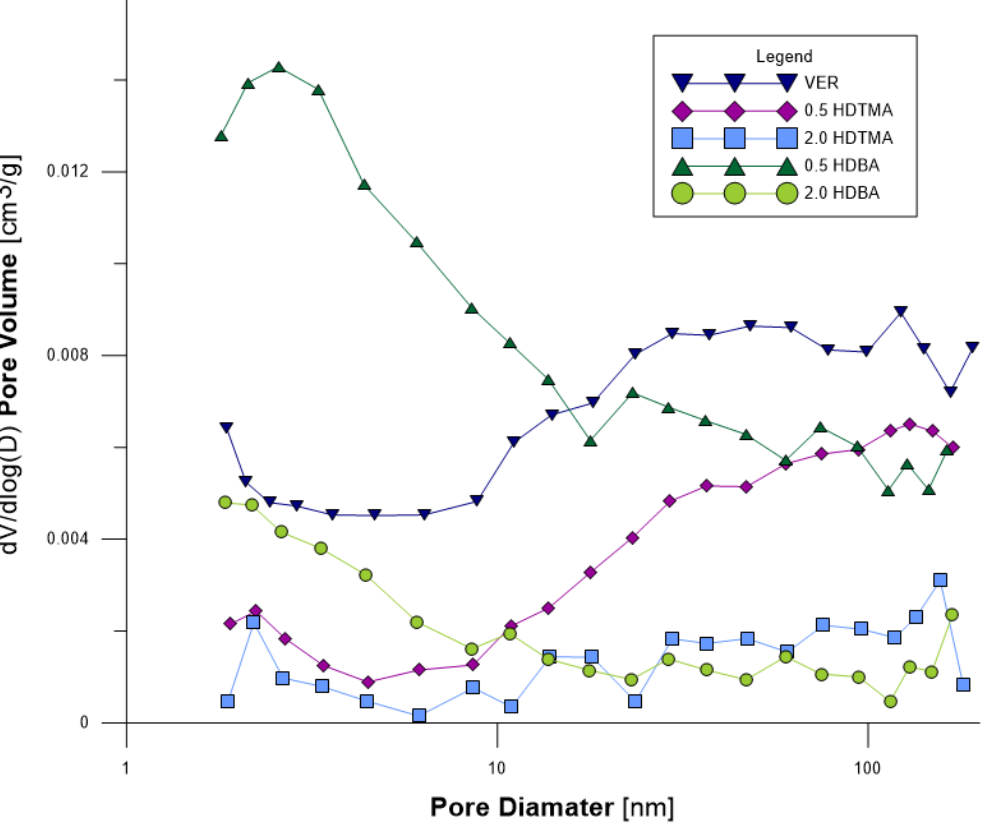
Figure 5. Pore size distribution for VER, 0.5 and 2.0 HDTMA, and 0.5 and 2.0 HDBA.